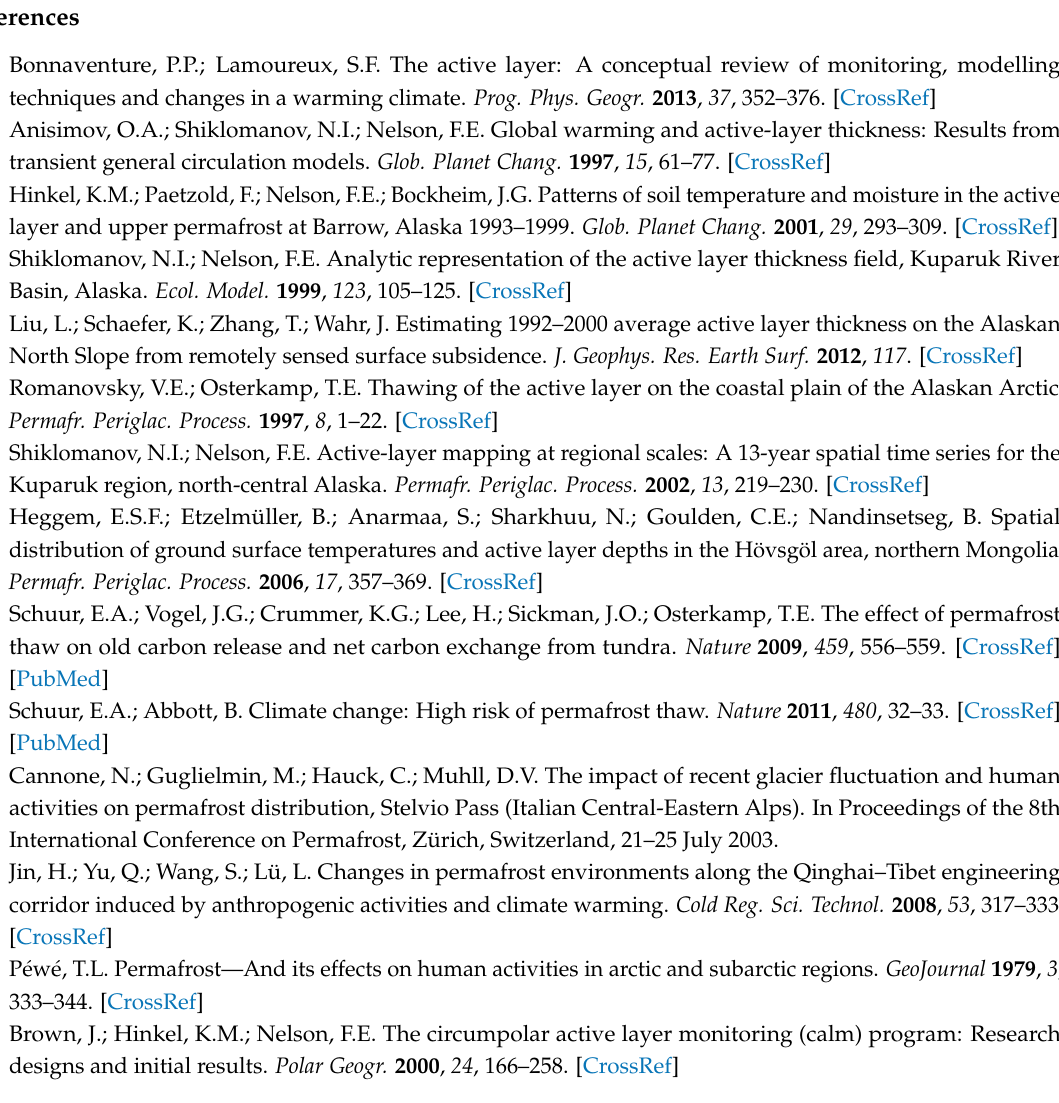
s1, Table S1: Meteorological stations used in this study; Table S2: The coordinates information of validation points used in this study; Figure S1: The dominant tree species ( Larix gmelinii ) in the study area; Figure S2: The workflow of data processing in this study; Figure S3: Interannual variations of air temperature in the study area; Figure S4: Mean active layer thickness (ALT) from 2000 to 2015 and DEM in the study